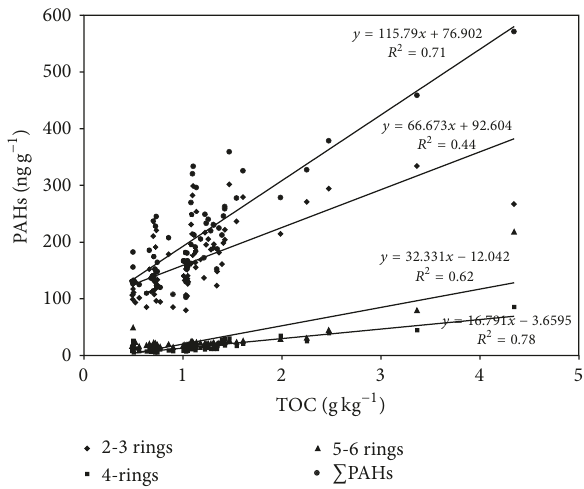
Figure 6: Relationship between TOC and PAHs